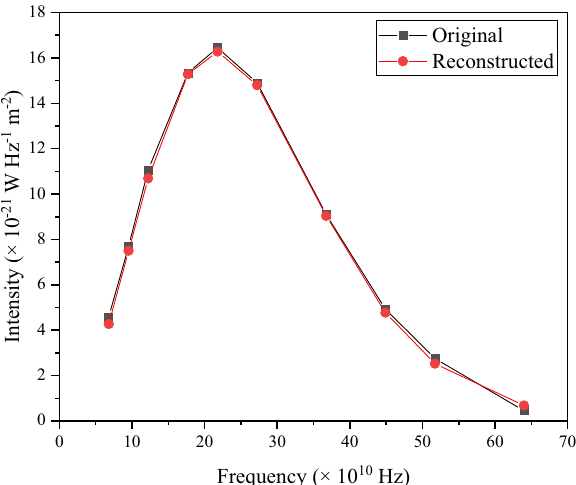
Figure 4. The original input intensity data for the dipole spectrum is reconstructed using the obtained probability distribution of temperature α d (T). Plots of experimental and reconstructed intensities versus frequency are shown.